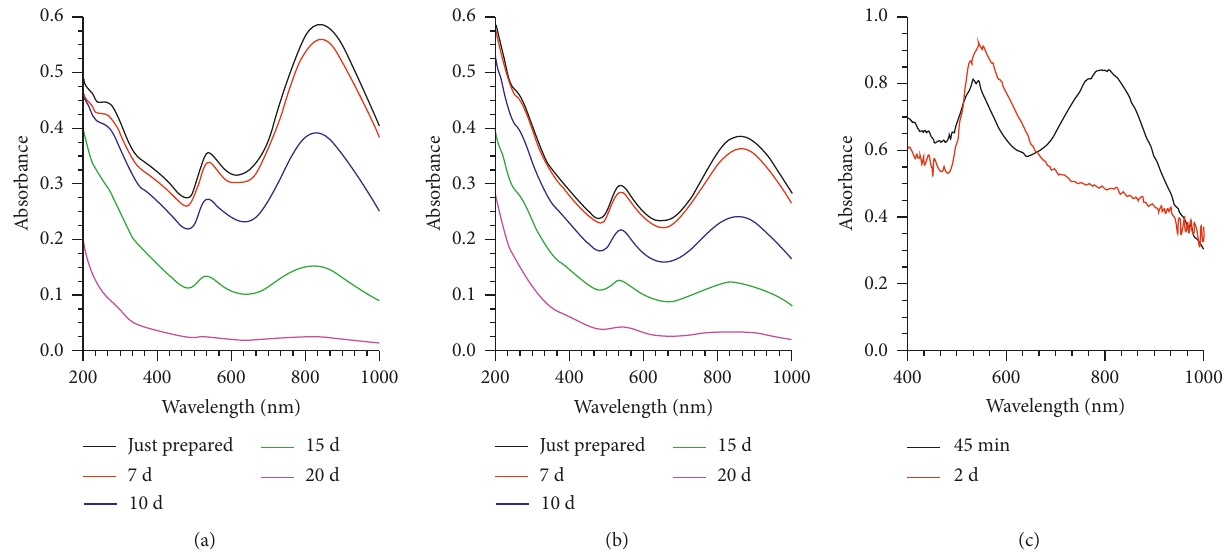
Figure 5: Time stability of naked AuNPs obtained for different molar ratios: (a) R